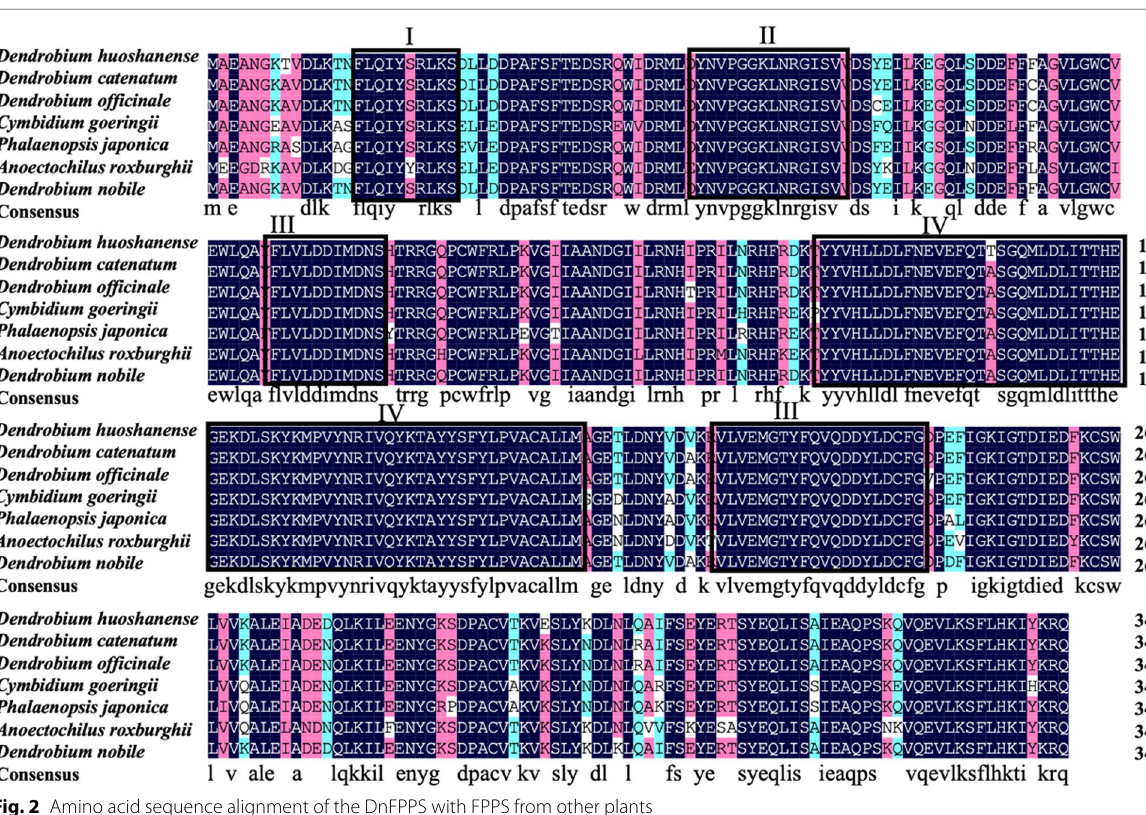
Fig. 2 Amino acid sequence alignment of the DnFPPS with FPPS from other plants